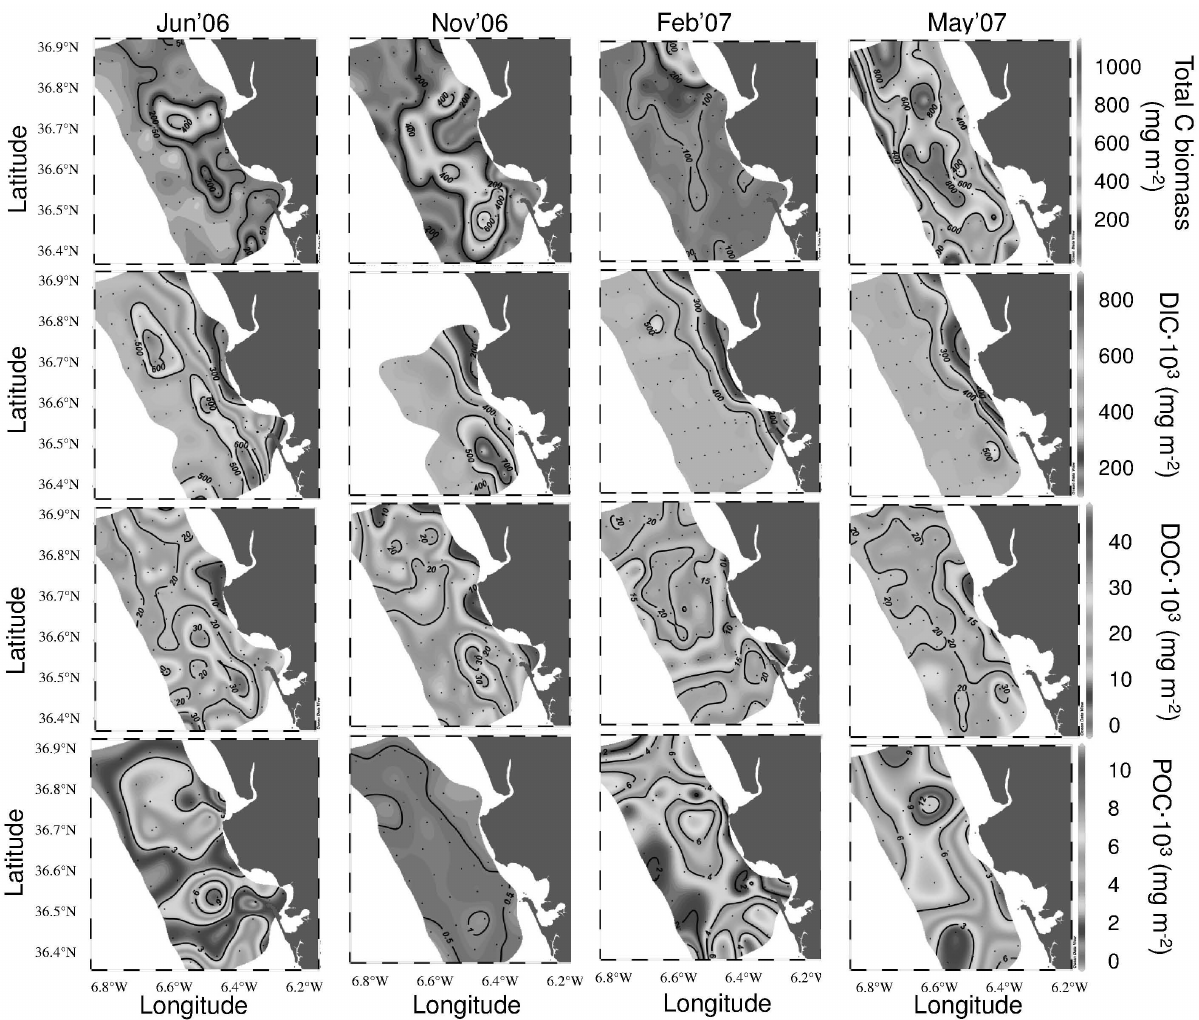
Fig. 6. – Contour plot showing the integrated total carbon biomass, dissolved inorganic carbon, dissolved organic carbon and particulate organic carbon (all in mg m –2 ) of the continental shelf of the Gulf of